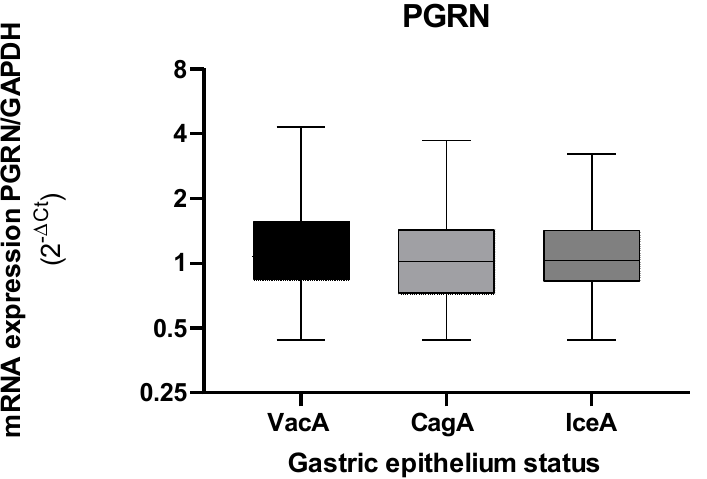
Figure 5. Expression levels of GRN mRNA in gastric tissue according to the virulence of H. pylori bacteria that present the vacA, cagA, and iceA . The GRN expression values calculated with the following formula: 2 − ∆ Ct , where ∆ Ct = Ct of GRN − Ct of GAPDH. Virulence factors were calculated by an amplification of the vacA , cagA , and iceA genes with the PCR method. The Kruskal–Wallis and Mann–Whitney tests were used for the analysis in or between the groups. Statistical significance was established at